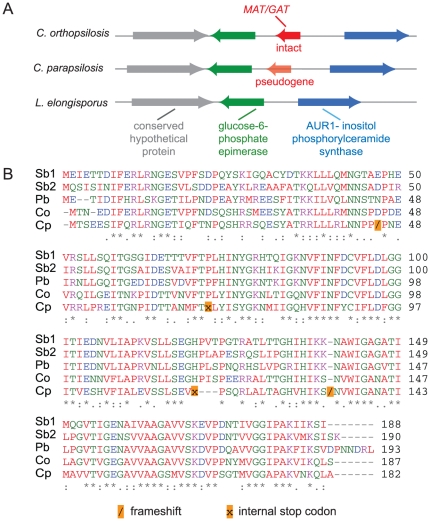
Horizontal Gene Transfer of a member of the MAT/GAT family in C. orthopsilosis.(A) Gene order surrounding the MAT/GAT gene in C. orthopsilosis, and the syntenic regions in C. parapsilosis and L. elongisporus. The grey, green and blue arrows represent conserved genes in all three species. The solid red arrow represents an intact ORF in C. orthopsilosis; the transparent red arrow represents a pseudogene in C. parapsilosis. (B) Multiple alignment of the predicted MAT/GAT proteins from Sphingobacterium (Sb1 = ZP_03969495.1, Sb2 = YP_004319944.1), Pedobacter (Pb, YP_003093425.1), C. orthopsilosis (Co) and C. parapsilosis (Cp). Yellow squares mark the presence of frameshifts (forward slash) and internal stop codons (x) that result in a pseudogene in C. parapsilosis.